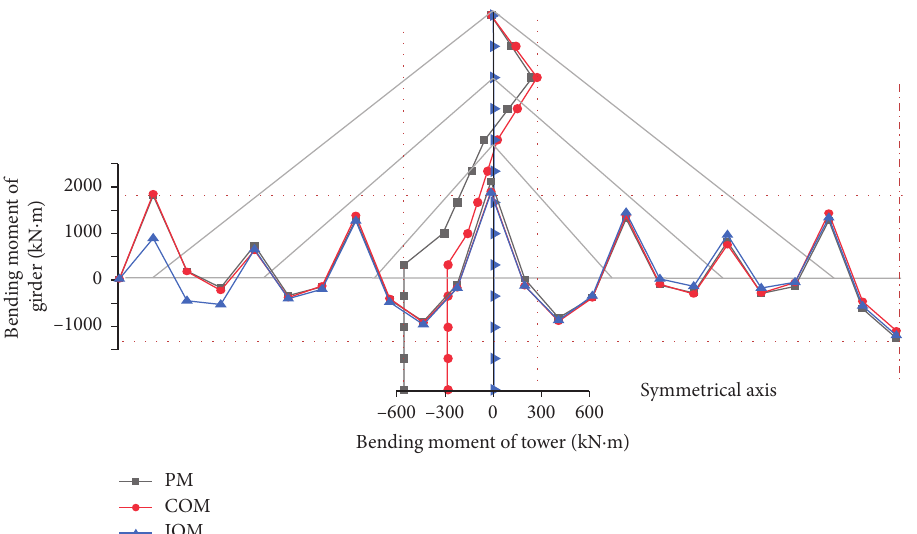
Figure 8: Comparison of bending moment of the simple cable-stayed bridge